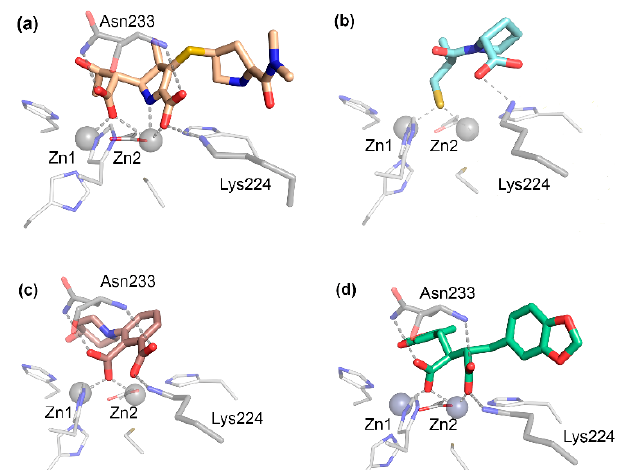
Figure 9. Binding modes of the product and intermediate mimic inhibitors. Crystal complexes of ( a ) NDM-1:meropenem hydrolysis product (PDB 4eyl) [69], ( b ) IMP-1:D-captopril (PDB 4c1g) [169], ( c ) a 3-aminophtalic acid inhibitor with IMP-1 (PDB 3wxc) [226], and ( d ) IMP-1: 24 (PDB 1jjt) [173]. Hydrogen bonds and metal ligands interactions are drawn with dashed lines.